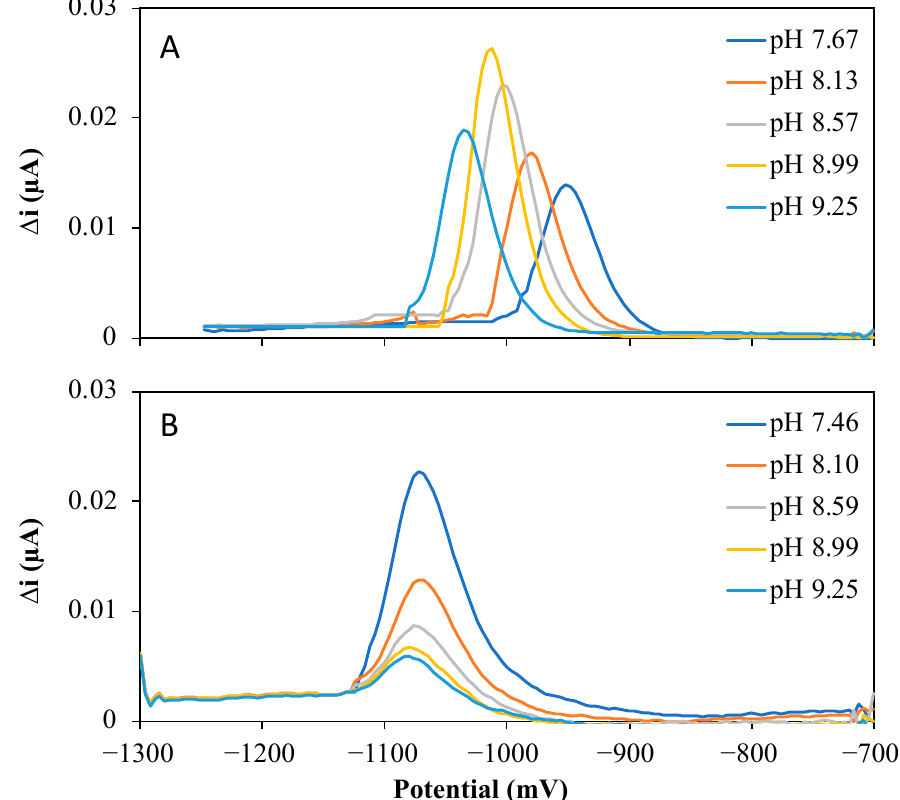
Figure 2. Influence of pH on the Ni(II) peak current intensity and peak potential in both synthetic media ( A ) and UV-SW ( B ). The solutions both contained 10 − 5 M nioxime. The concentration of Ni(II) was 12 nM in the synthetic media and 6 nM in UV-SW.